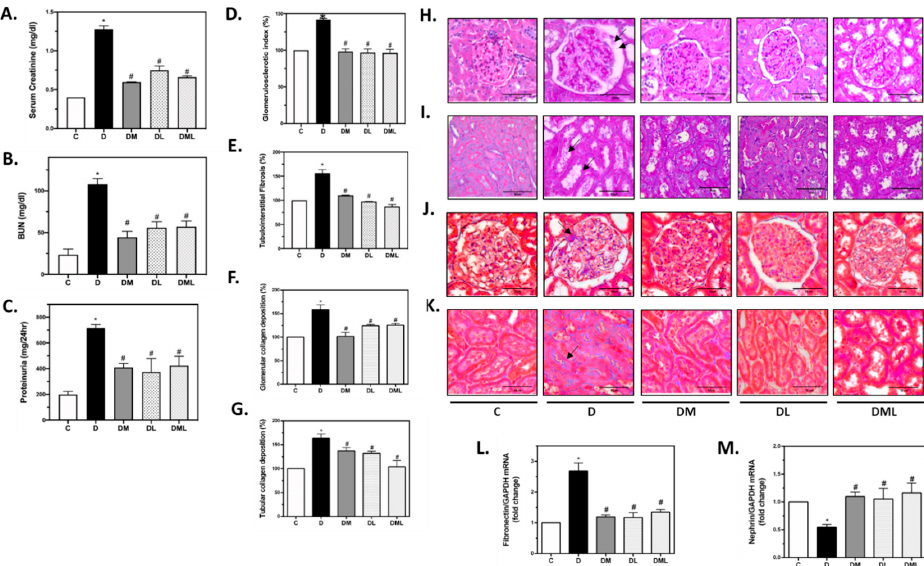
Figure 1. Effect of the GLP1-RA, liraglutide, the AMPK activator, metformin or their combination on kidney injury. ( A ,B) Bar plots representing SCr and BUN concentrations respectively. ( C ) Bar plot reflecting the quantification of proteinuria. ( D , E ) Bar plots representing the glomerulosclerotic and tubulointerstitial fibrosis index (%) respectively. ( H , I ) Representative microphotographies of glomerular and tubular PAS stain respectively with black arrows pointing to the injury (magnification 40 × , scale bar 50 µ m). ( F , G ) Bar plots representing the quantification of the glomerular and tubular collagen deposition (%). ( J , K ) Representative microphotographies of glomerular and tubular MT stain with black arrows pointing to the collagen deposition (Magnification 40 × , scale bar 50 µ m). ( L , M ) Bar plots representing the differential expression of fibronectin and nephrin mRNA expression normalized against GAPDH expression respectively. GAPDH: glyceraldehyde 3-phosphate dehydrogenase. All data are expressed as mean ± SEM. * p ≤ 0.05 diabetic vs. control groups. # p ≤ 0.05 treated vs. diabetic groups.